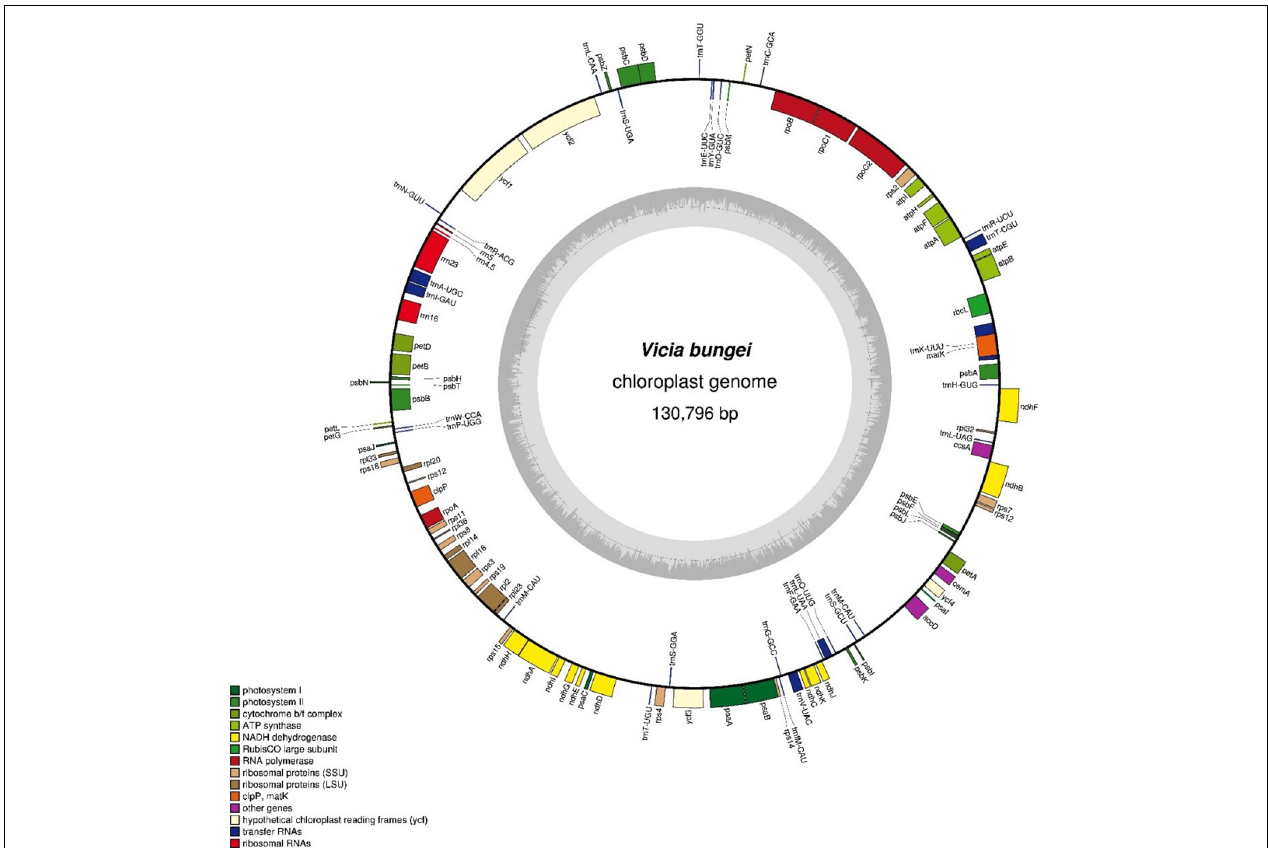
FIGURE 1 | Schematic map of the chloroplast genome of Vicia bungei .